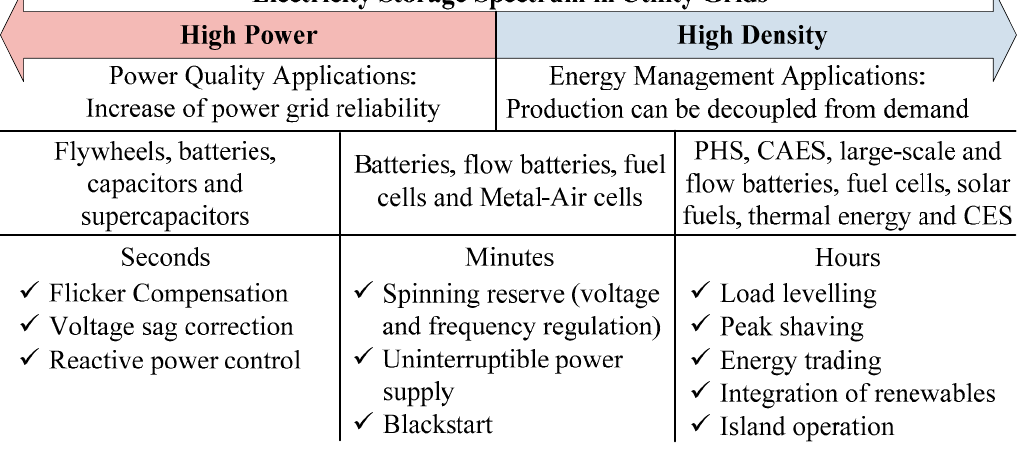
Figure 1. Energy storage systems technologies.